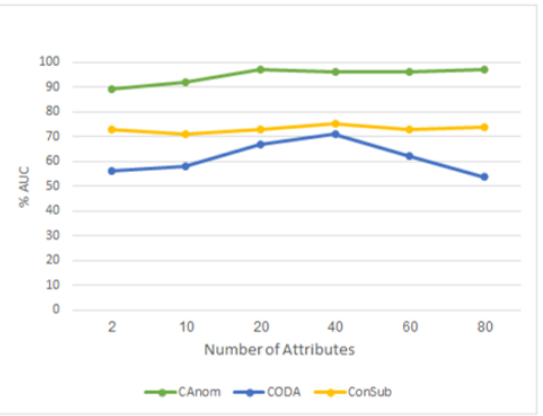
Figure 7. Variations in AUC according to the different number of attributes for each of the tested models.